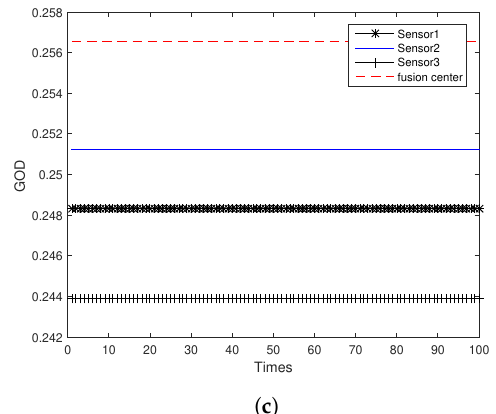
Figure 6. Observable degree comparison between local filter and fusion center in distributed multi-sensor fusion system with feedback: ( a ) LOD of Sx; ( b ) LOD of Vx; ( c ) GOD.